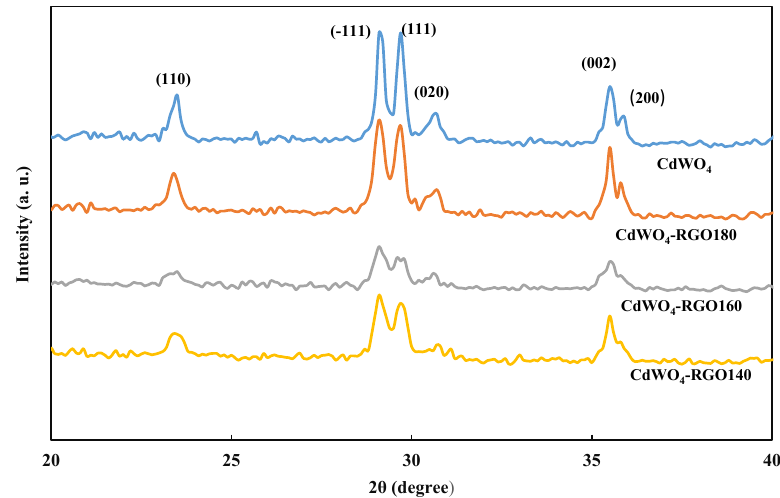
Fig. 1. XRD patterns of the pure CdWO